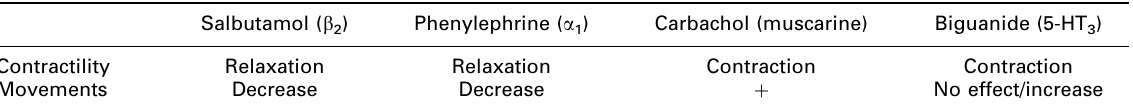
Table 2. Overview of contractile activities and number of movements of colonic segments induced by pharmacological